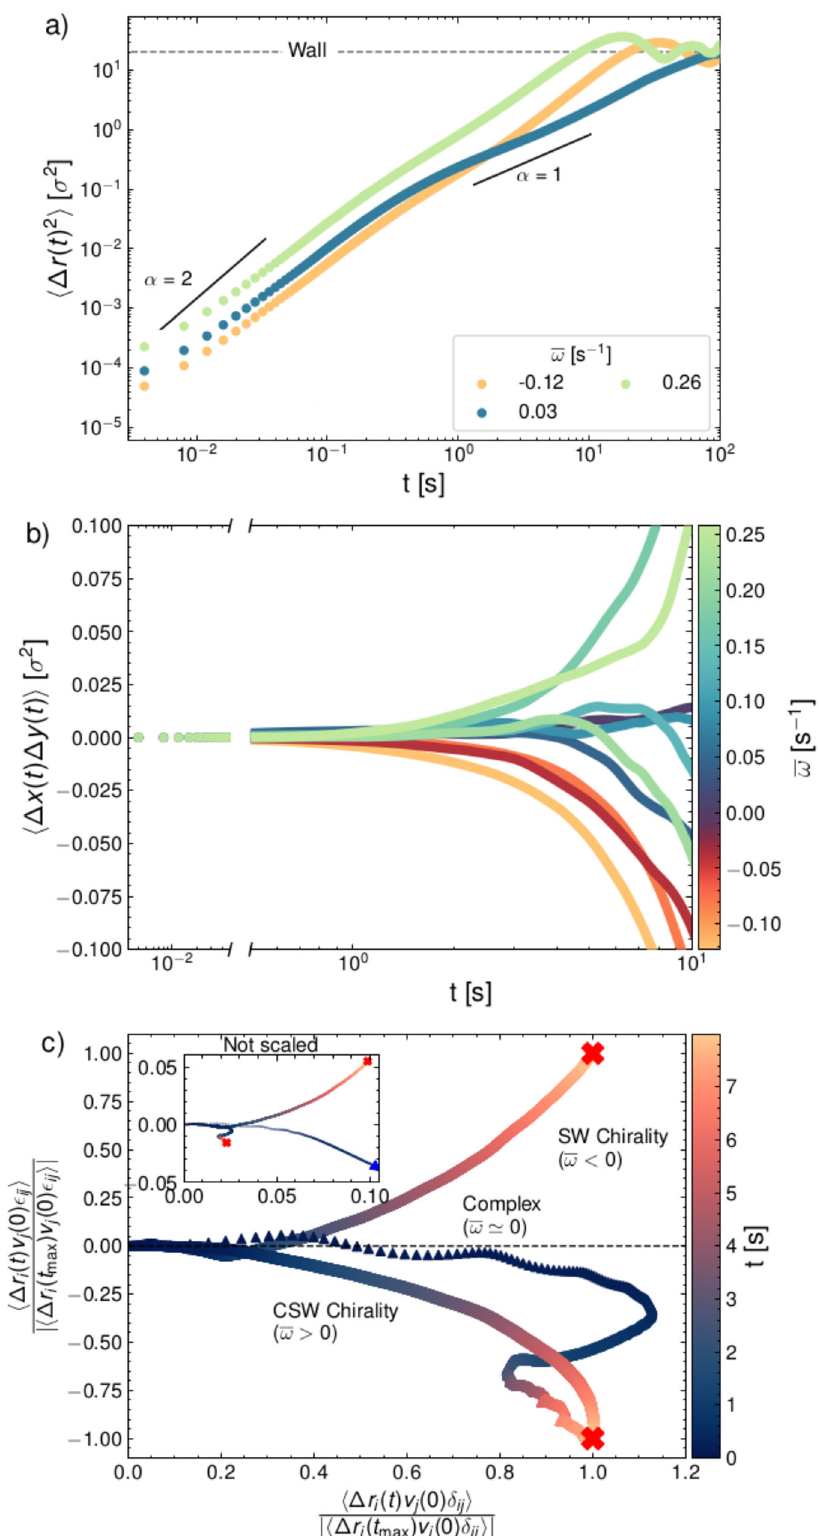
Fig. 1 Statistical properties of particle displacements. a Mean squared displacement 〈 Δ r(t) 2 〉 at three different global vorticities ω . The saturation value due to con fi nement is indicated with a dashed line. b Mean cross-displacements 〈 Δ x ( t ) Δ y ( t ) 〉 for several values of ω . c Position-velocity cross correlations for ω ¼ (cid:2) 0 : 12s (cid:2) 1 , ω ¼ 0 : 03s (cid:2) 1 , ω ¼ 0 : 26s (cid:2) 1 (indicated as ω < 0, ω ¼ 0, ω > 0 respectively). In the main panel of c , correlations are scaled with the corresponding value at t ¼ t max ¼ 8s (the last represented value in this case), while in inset shows the unscaled version. Packing fraction for a – c : ϕ = 0.45.